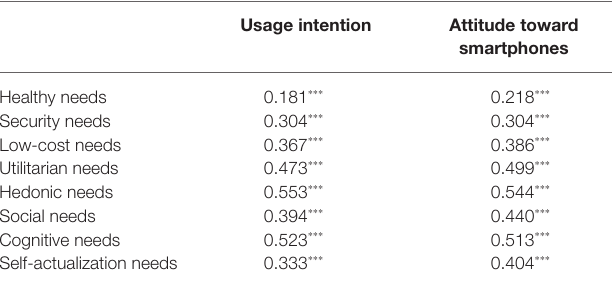
TABLE 5 | Pearson’s correlation between needs factors and usage intention and attitudes of smartphone.